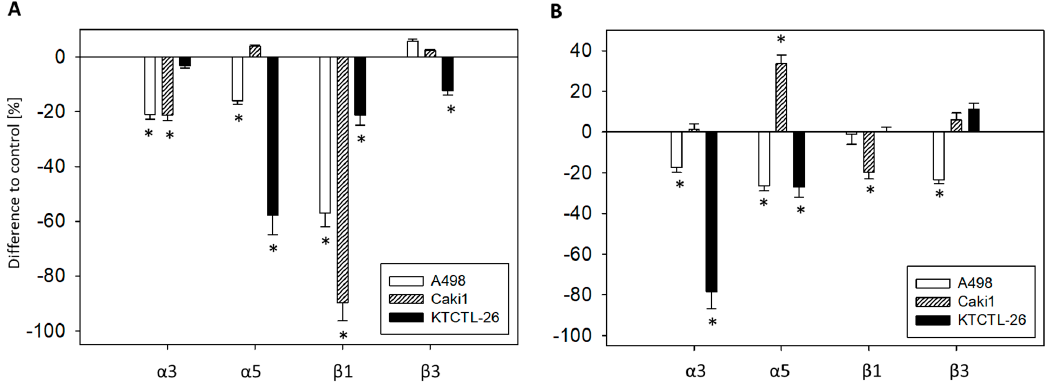
Figure 9. Adhesion to collagen ( A ) and chemotaxis ( B ) of A498, Caki1, and KTCTL-26 cells after block- ade of integrins α 3, α 5, β 1, or β 3. The untreated control is set to 0% (line drawn at 0%). 5 separate fields of 0.25 mm 2 were counted at 200× magnification (means ± SD, n = 6). * indicates significant difference to controls ( p = 0.00512). di ff erence to controls ( p =